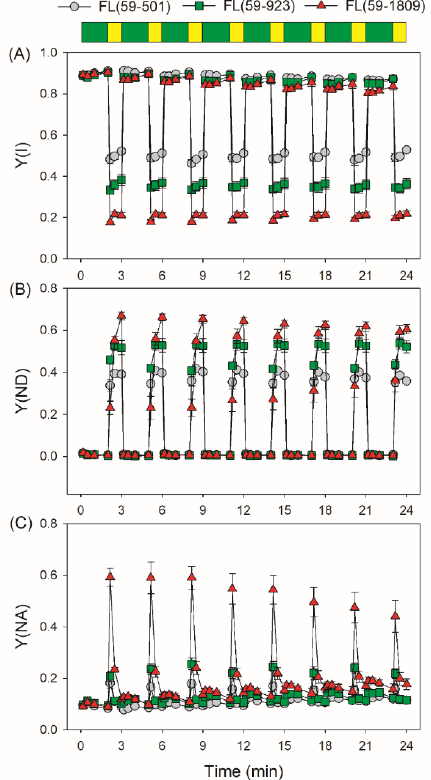
Figure 1. Changes in the PSI parameters under different fluctuating light conditions. After light adaptation at 1455 µ mol photons m − 2 s − 1 for 5 min to activate photosynthetic electron sinks, leaves were exposed to fluctuating light alternating between low (59 µ mol photons m − 2 s − 1 , 2 min) and high light (501, 923 or 1809 µ mol photons m − 2 s − 1 , 1 min). The PSI parameters were recorded in low light (10 s, 30 s, 60 s and 120 s) and high light (10 s, 30 s and 60 s). ( A ) Y(I), the quantum yield of PSI photochemistry; ( B ) Y(ND), the quantum yield of PSI non-photochemical energy dissipation due to donor-side limitation; and ( C ) Y(NA), the quantum yield of PSI non-photochemical energy dissipation due to acceptor-side limitation. Data are shown as the means ± SE ( n = 5). Green bars indicate low light (59 µ mol photons m − 2 s − 1 ); yellow bars indicate high light (501, 923 or 1809 µ mol photons m − 2 s − 1